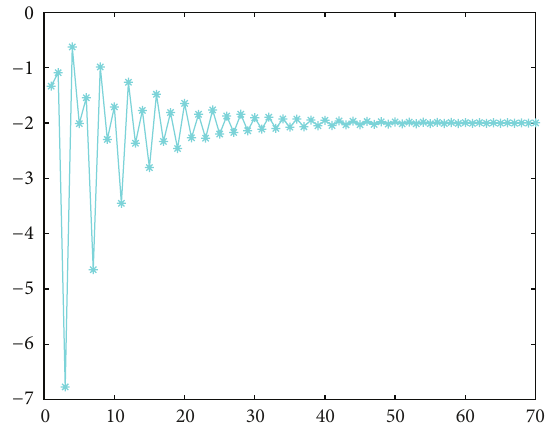
Figure 1: Evolution of 𝑥 𝑛+1 for (1) with parameters and initial condition given in Example 1.